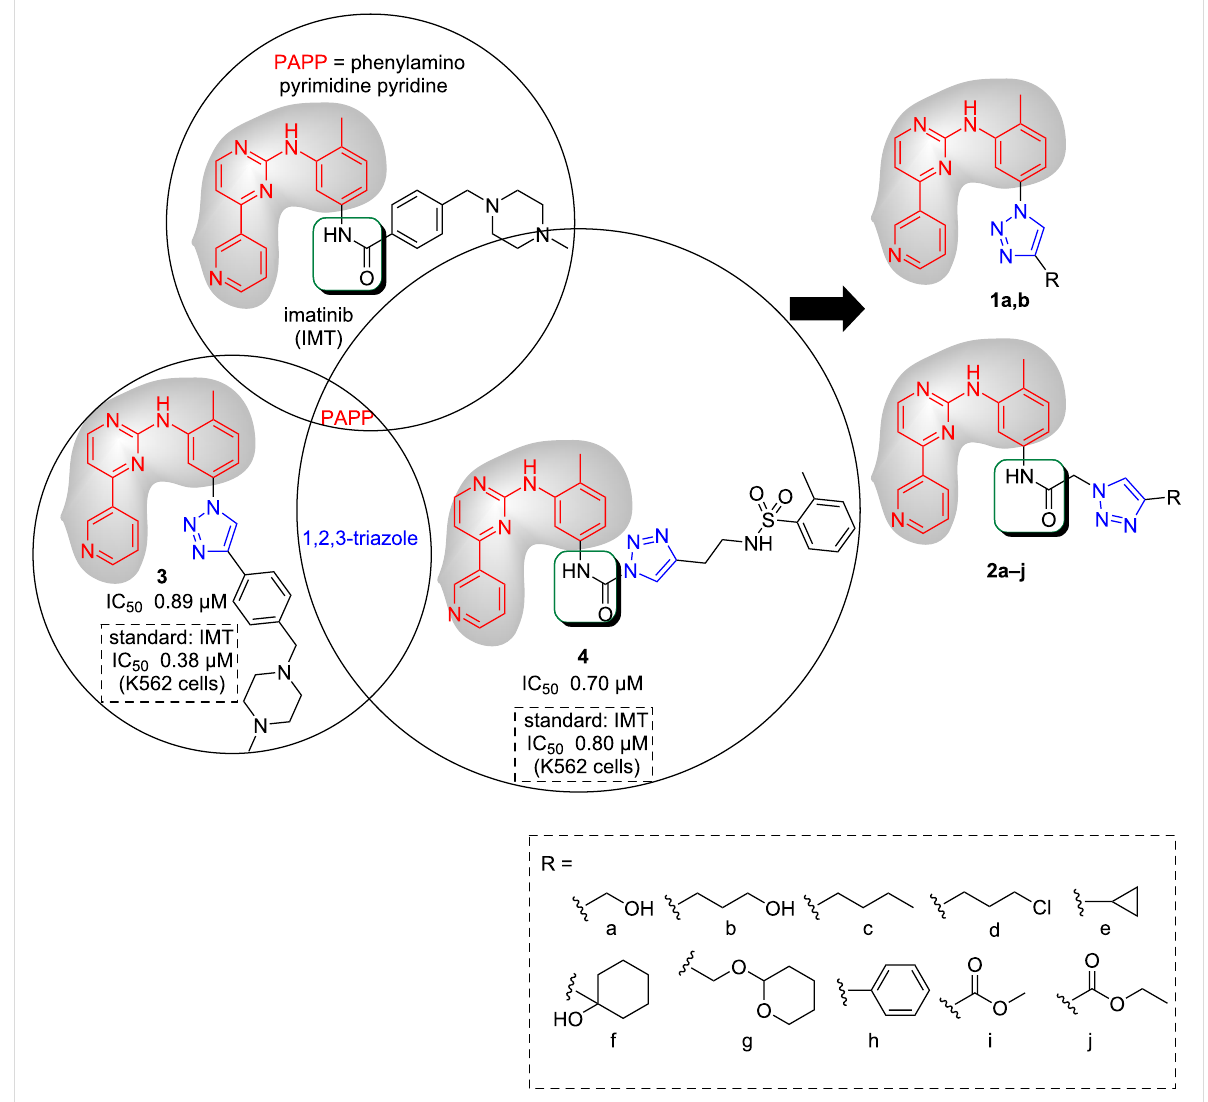
Figure 1: Proposed structural modifications to obtain triazole derivatives 1a , b and 2a – j .